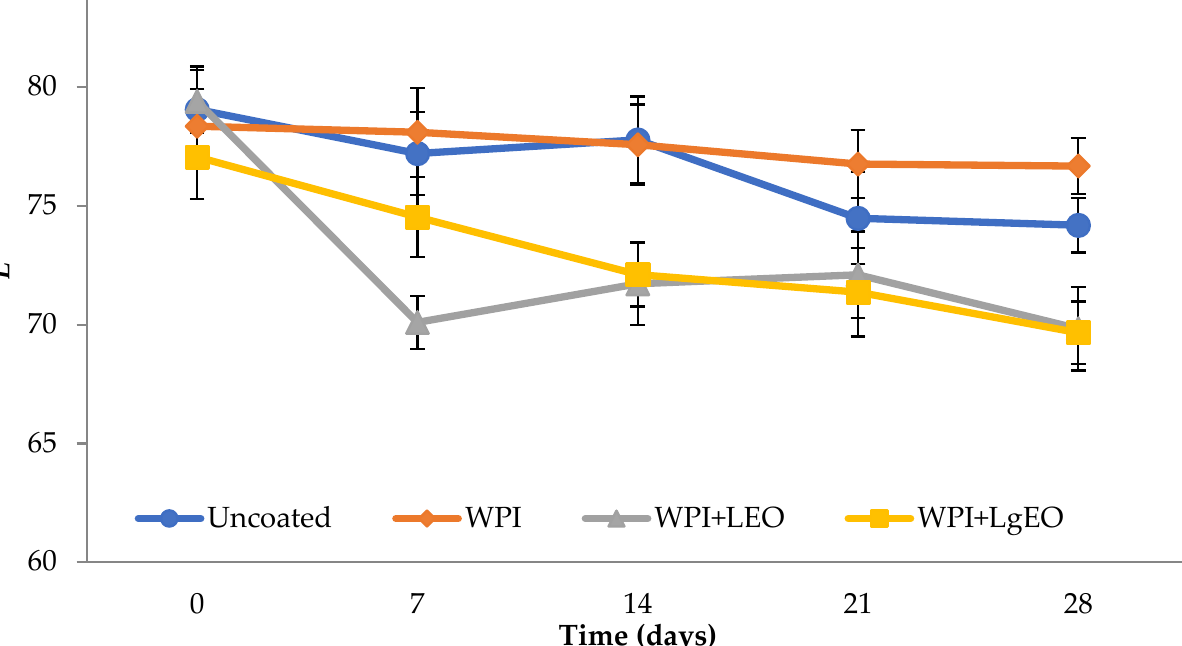
Figure 1. Lightness (Parameter L *) of fresh-cut pears coated with whey protein isolate coatings (WPI) incorporated with lemon (WPI + LEO) and lemongrass (WPI + LgEO) essential oils or uncoated samples during 28 days of storage at 4 °C.